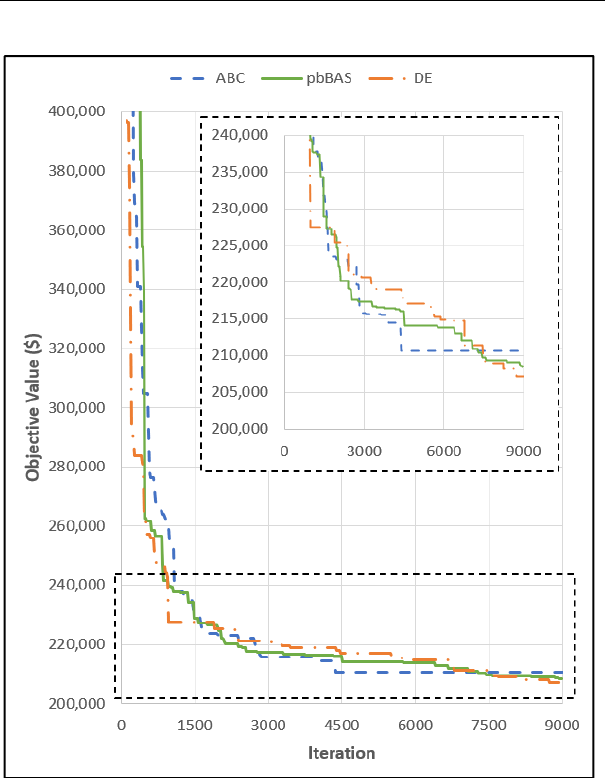
Figure 18. Design history of the best run achieved by each metaheuristic algorithm for the three- segment type folded plate roof problem.